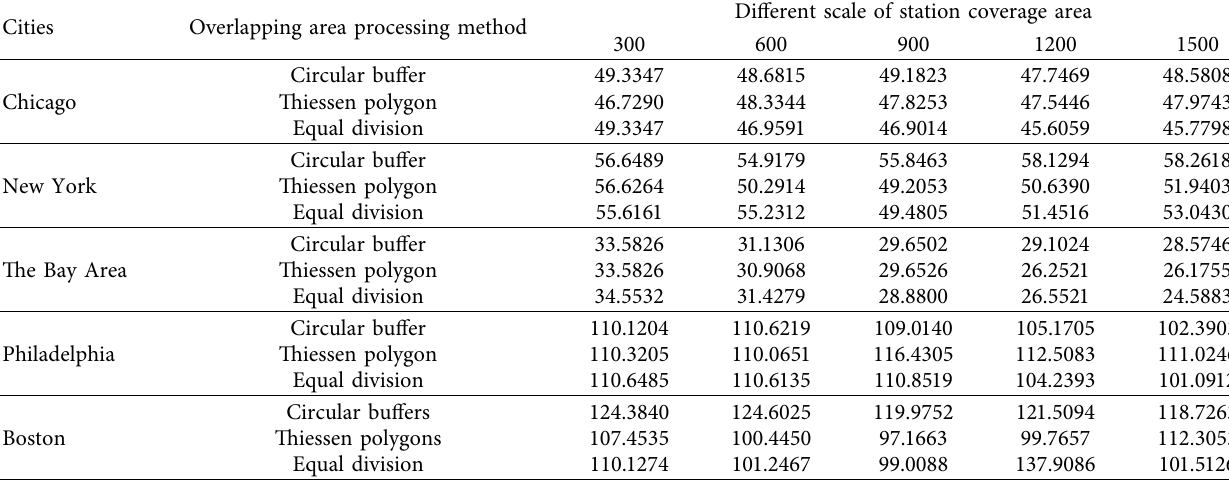
Table 9: Table of the MAPE of log-linear regression model in five